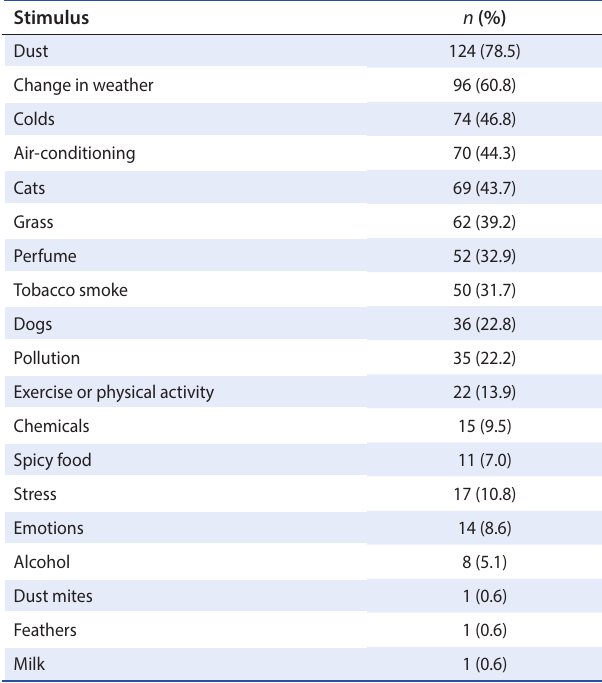
Table 3: Stimuli that trigger or worsen symptoms of allergic rhinitis ( n = 158) Stimulus n (%)